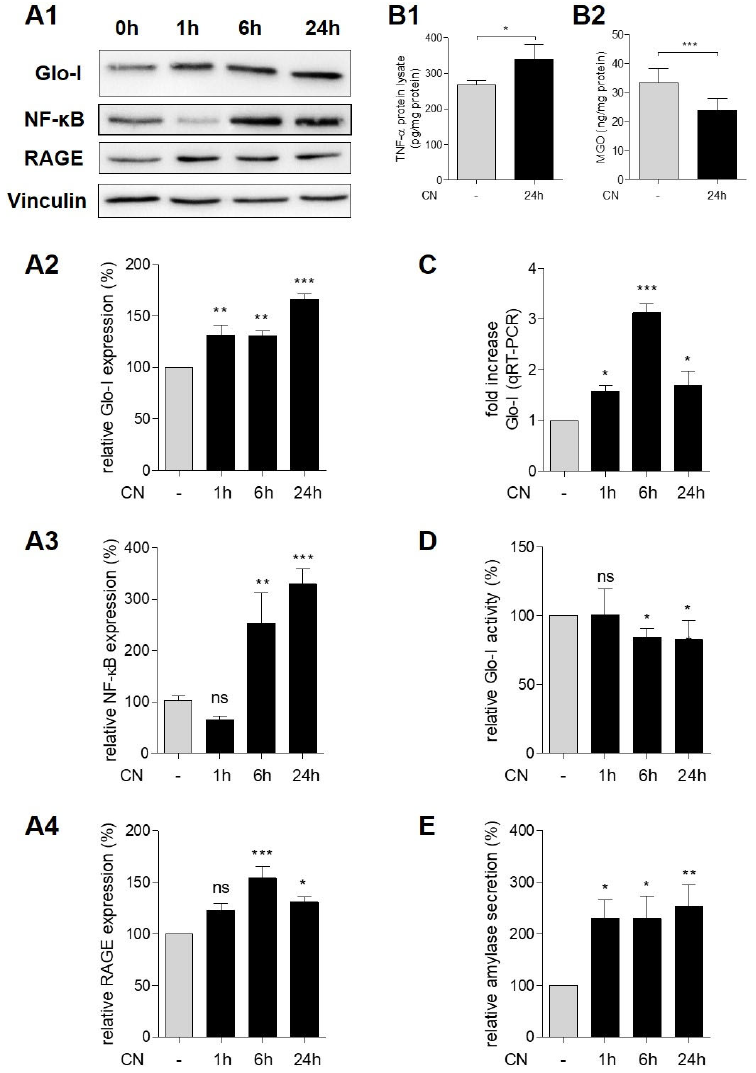
Figure 3. Effect of CN on inflammatory markers and amylase in AR42J. ( A1 – A4 ) Western blot anal ‐ ysis of CN ‐ induced stimulation of Glo ‐ I, NF ‐κ B and RAGE. Representative images indicate time ‐ dependent stimulation of Glo ‐ I, NF ‐κ B and RAGE. Vinculin was used as a housekeeping marker ( A1 ). Quantifications of Glo ‐ I ( A2 ), NF ‐κ B ( A3 ) and RAGE ( A4 ) showed statistically significant stim ‐ Quantifications of Glo-I ( A2 ), NF- κ B ( A3 ) and RAGE ( A4 ) showed statistically significant